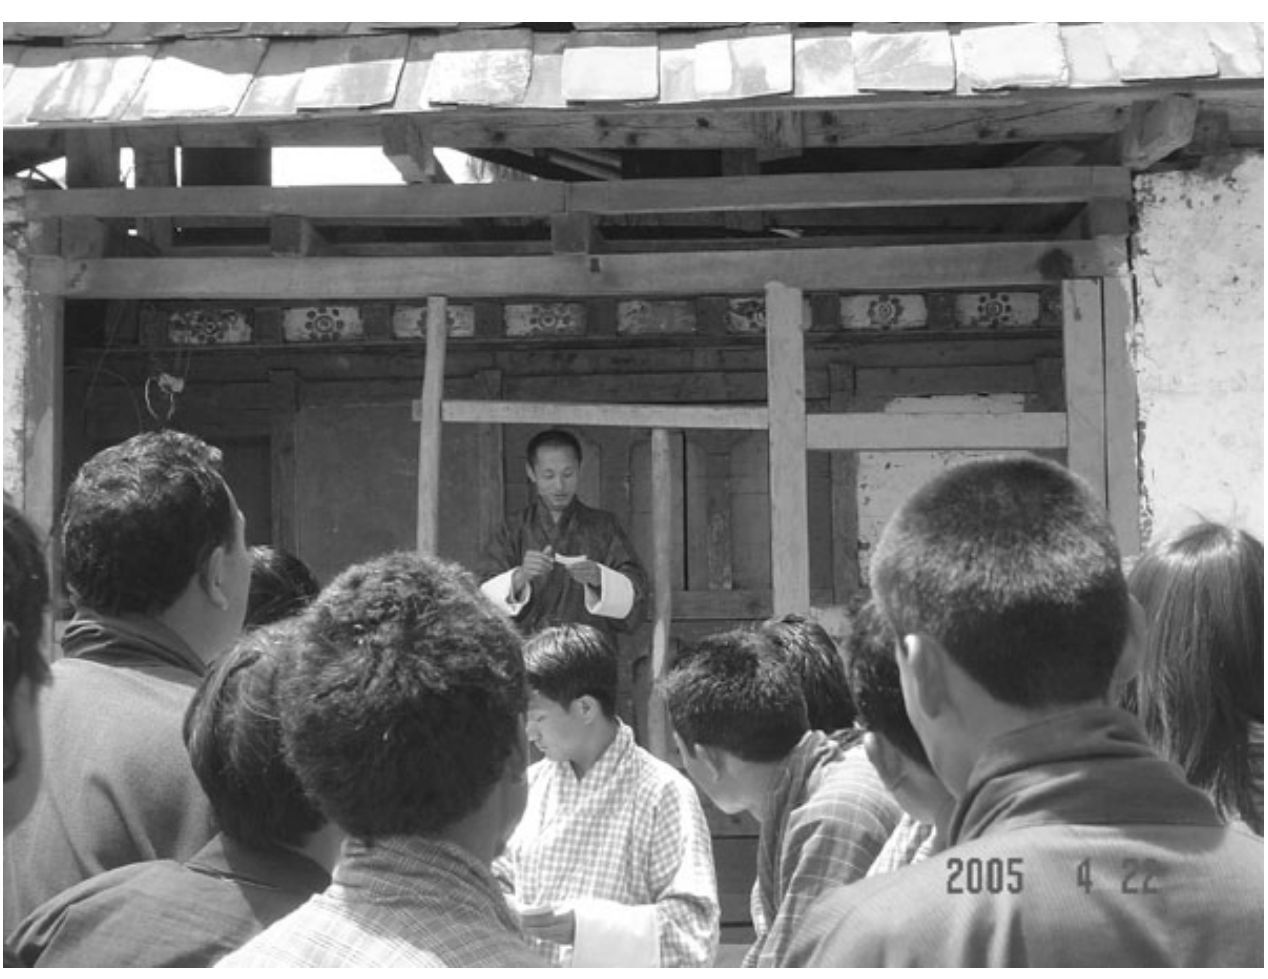
Fig. 10. Facilitator declaring the collective impact after one time